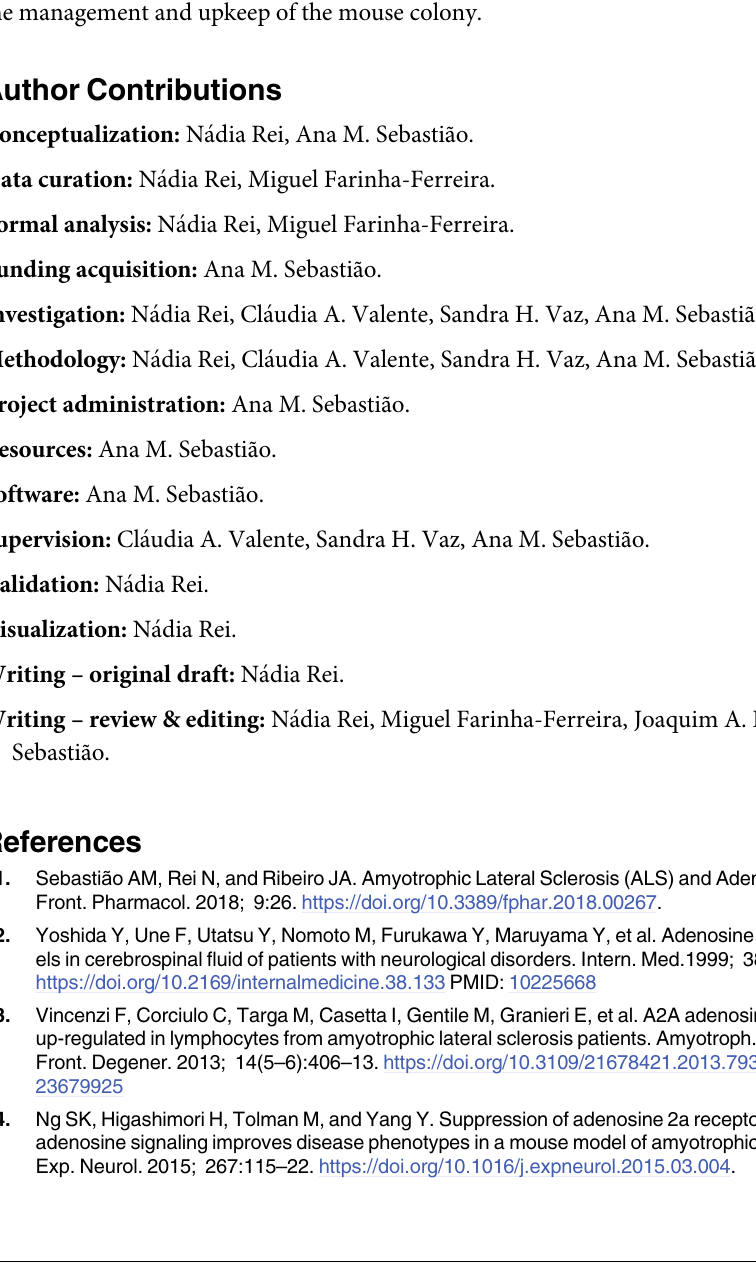
S1 Table. Primers used in the qRT-PCR